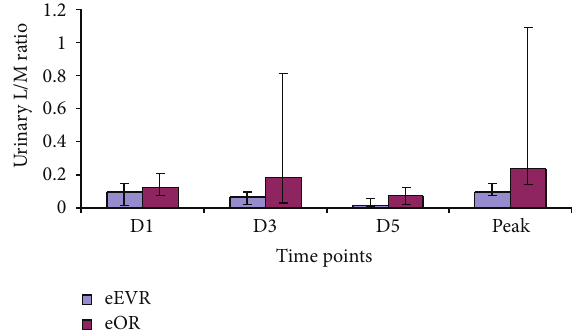
Figure 8: AUC 120 for plasma paracetamol concentration expressed as median and IQR ( 𝜇 g/mL/min). 𝑃 = 0.03 , D1 versus D3 in eEVAR group (Wilcoxon signed ranks test).